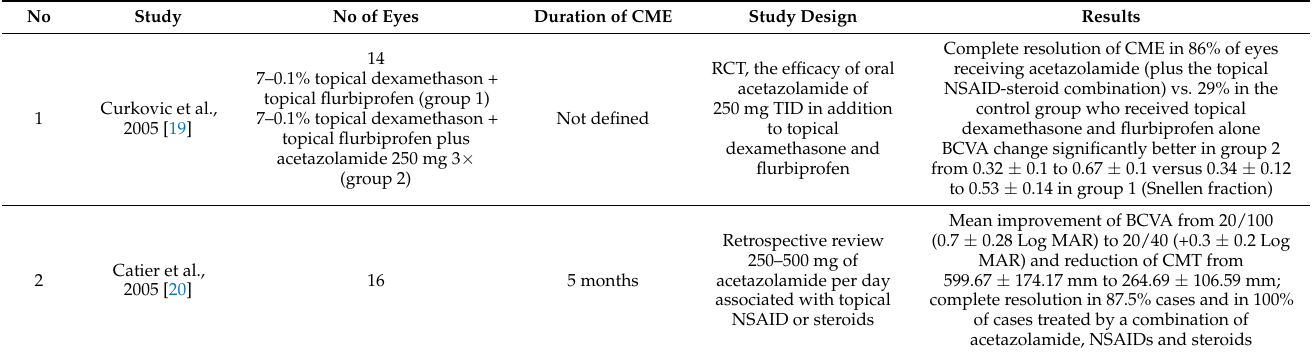
Table 2. Results of the studies analyzing the efficacy of CAI in the treatment of IGS that involved at least 10 cases and were published since 2000.